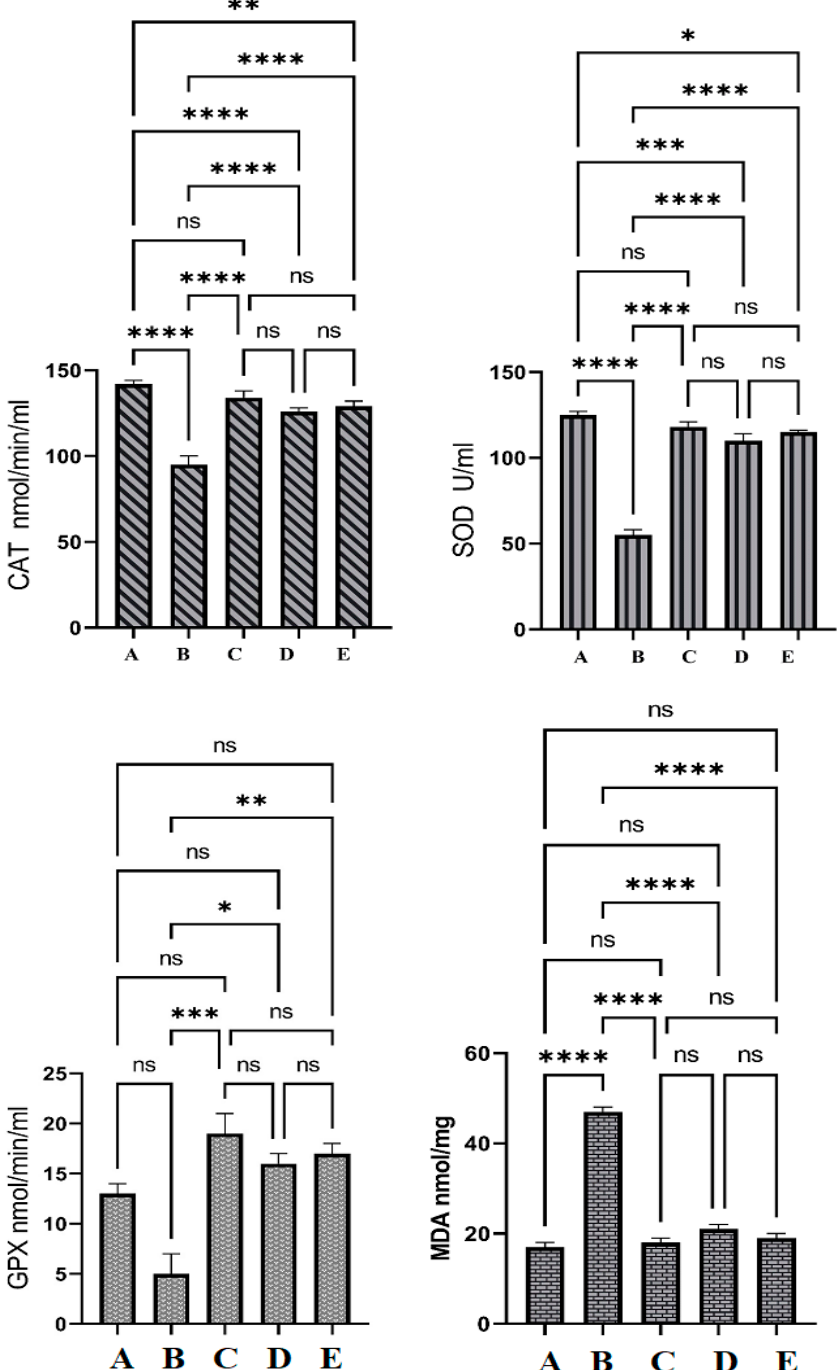
Figure 7. The antioxidant effects of OME in Azoxymethane (AOM) induced the aberrant crypt foci in rats. ( A ), normal control group; ( B ), cancer control group; ( C ), reference group; ( D ), rats supplemented with 200 mg/kg of OME; ( E ), rats treated with 400 mg/kg of OME. Cancer control had significantly lower endogenous antioxidant enzymes and higher lipid peroxidation values compared to all other groups. Non-significant changes in antioxidant measurements were observed between C, D, and E groups. ns, non-significant; *, means significant at p < 0.05; **, means significant at p < 0.01; ***, means significant at p < 0.001; ****, means significant at p < 0.0001.